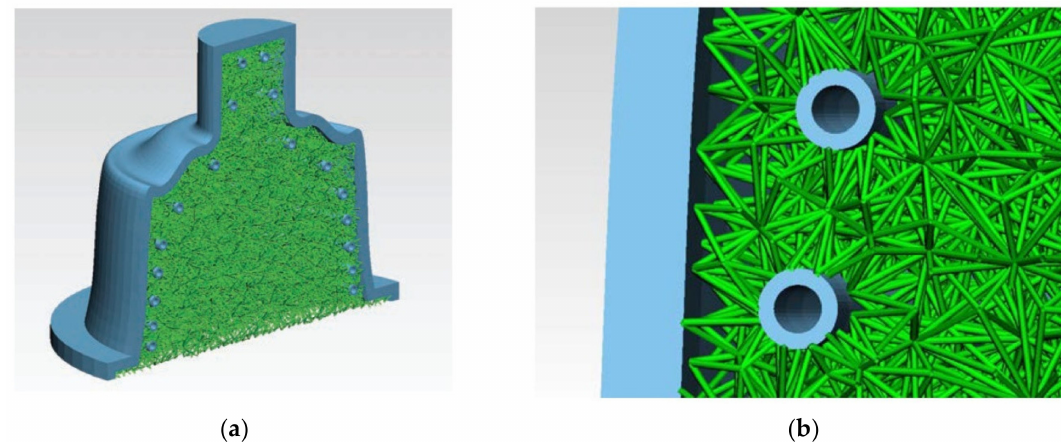
Figure 30. A split mould tool with internal lattice structure in green ( a ) and a close view of the same mold ( b ) [143]. ( a ) Height = outer diameter = 200 mm. ( b ) Outer skin thickness = 6 mm and lattice structure = 0.5 mm